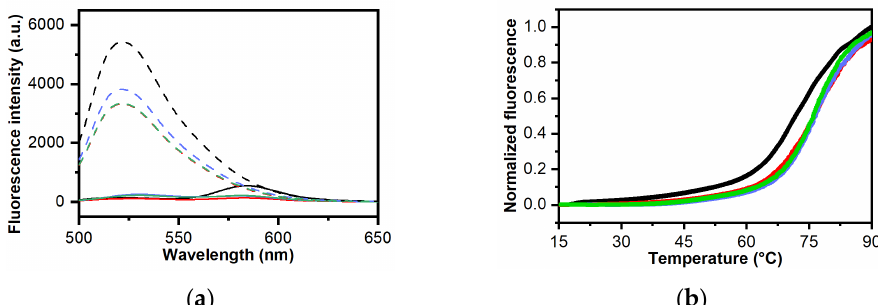
Figure 3. ( a ) Fluorescence emission spectra recorded at 15 °C (solid lines) and 90 °C (dashed lines); ( b ) FRET melting experiments for F-TERRA-T (0.2 µM) in the absence (black) and presence (red) of BPBA (2.0 µM). Experiments in the presence of BPBA were also performed by adding a large excess of Hrp 27 duplex competitor (6.0 µM, blue; and 20.0 µM, green).